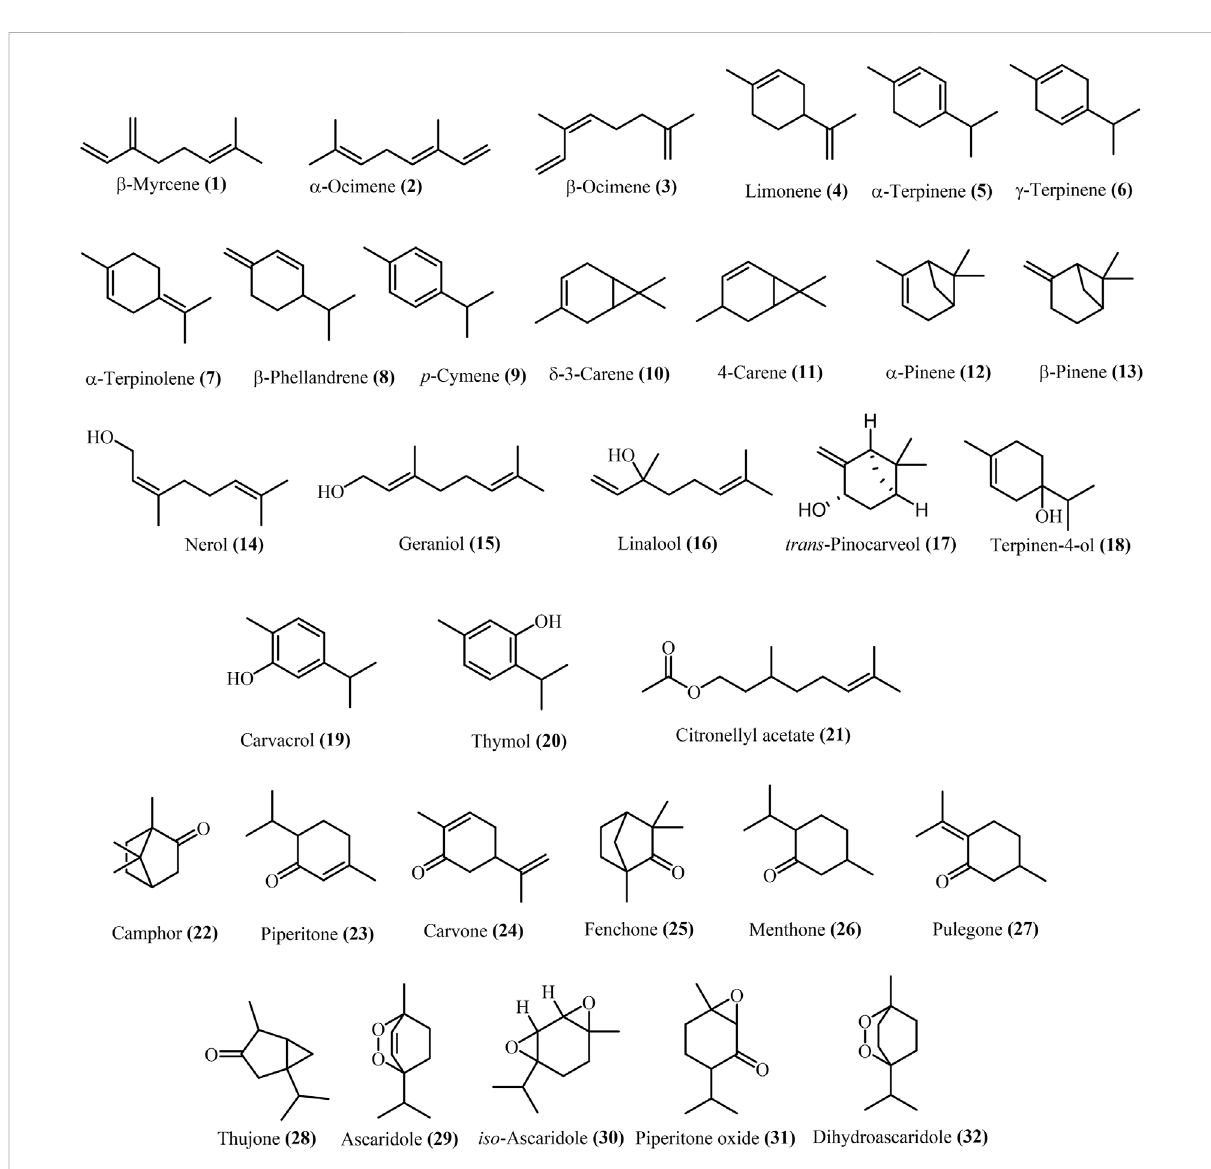
FIGURE 3 Monoterpenes of Dysphania spp essential